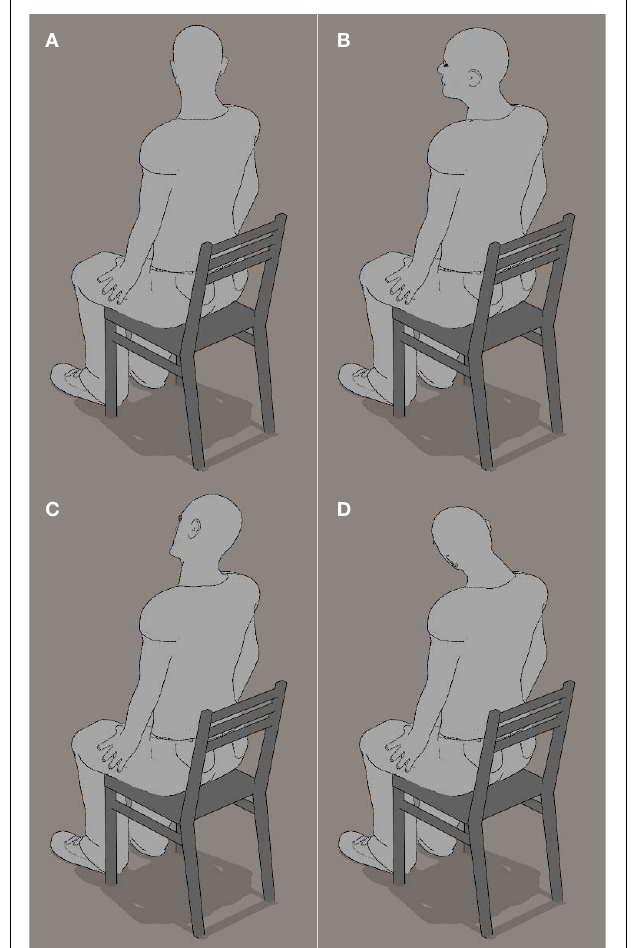
FIGURE 10 |The main component axes of average spontaneous head rotations. (A,B) Head turn about vertical Z axis. (C,D) Head tilt about naso-occipital Y